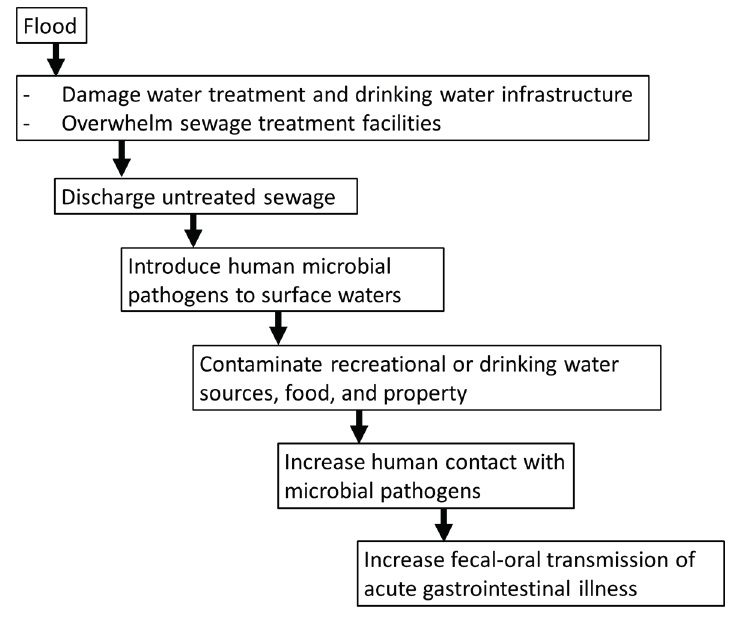
Figure 1. How flooding can facilitate the transmission of acute gastrointestinal